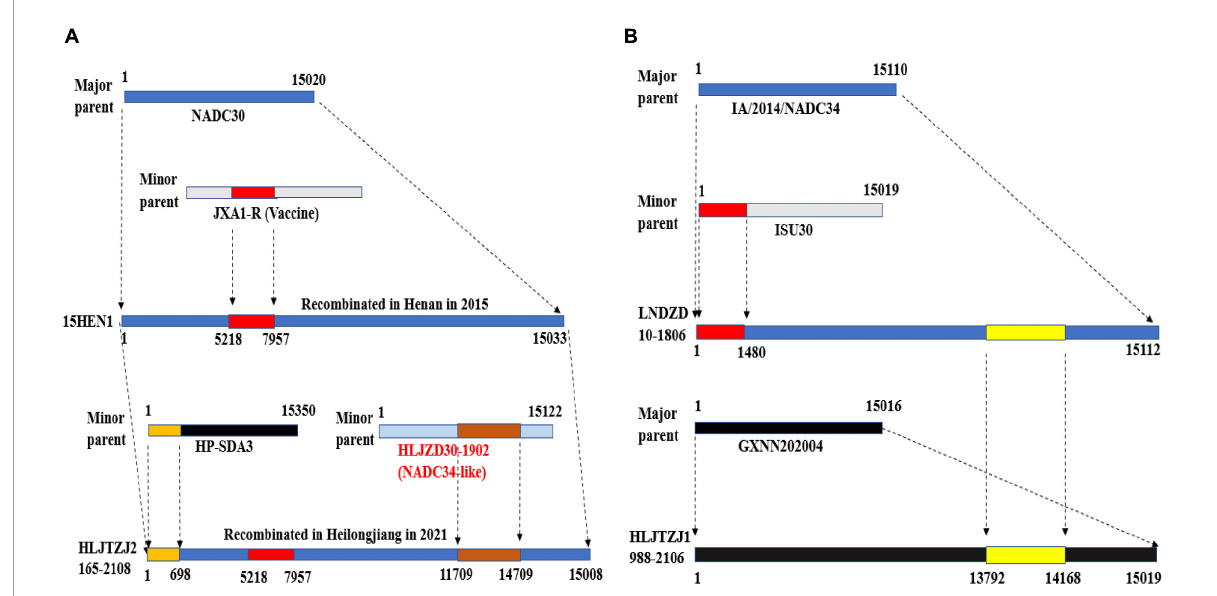
FIGURE5 Schematic diagram of the recombination of HLJTZJ2165-2108, LNDZD10-1806, and HLJTZJ1988-2106 strains. (A) Origin of HLJTZJ2165-2108 strain. (B) Origin of strains LNDZD10-1806 and HLJTZJ1988-2106. Maps produced using Adobe Illustrator CC 2019 (Adobe Inc., San Jose, CA, United